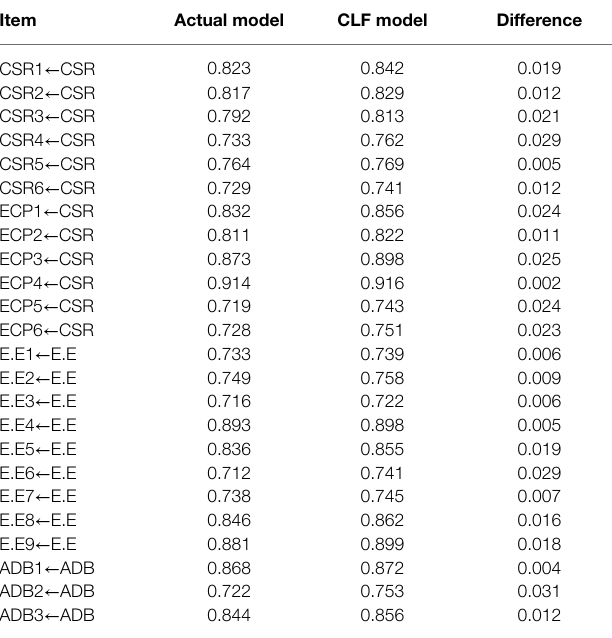
TABLE 3 | Common latent factor (CLF) results.